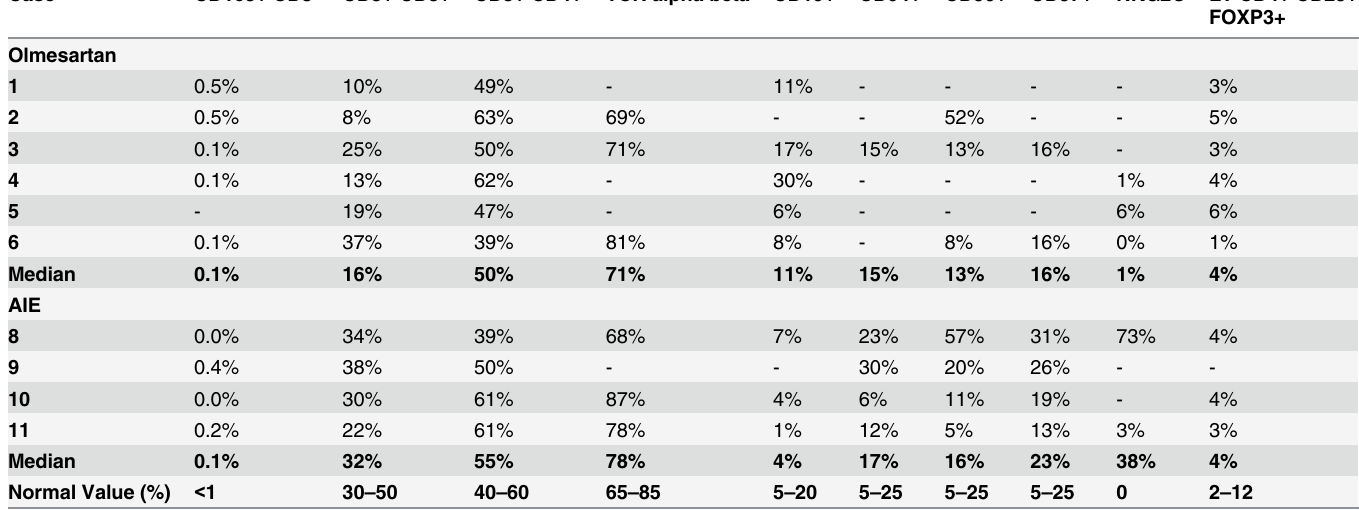
Table 4. Phenotype of peripheral blood lymphocytes.